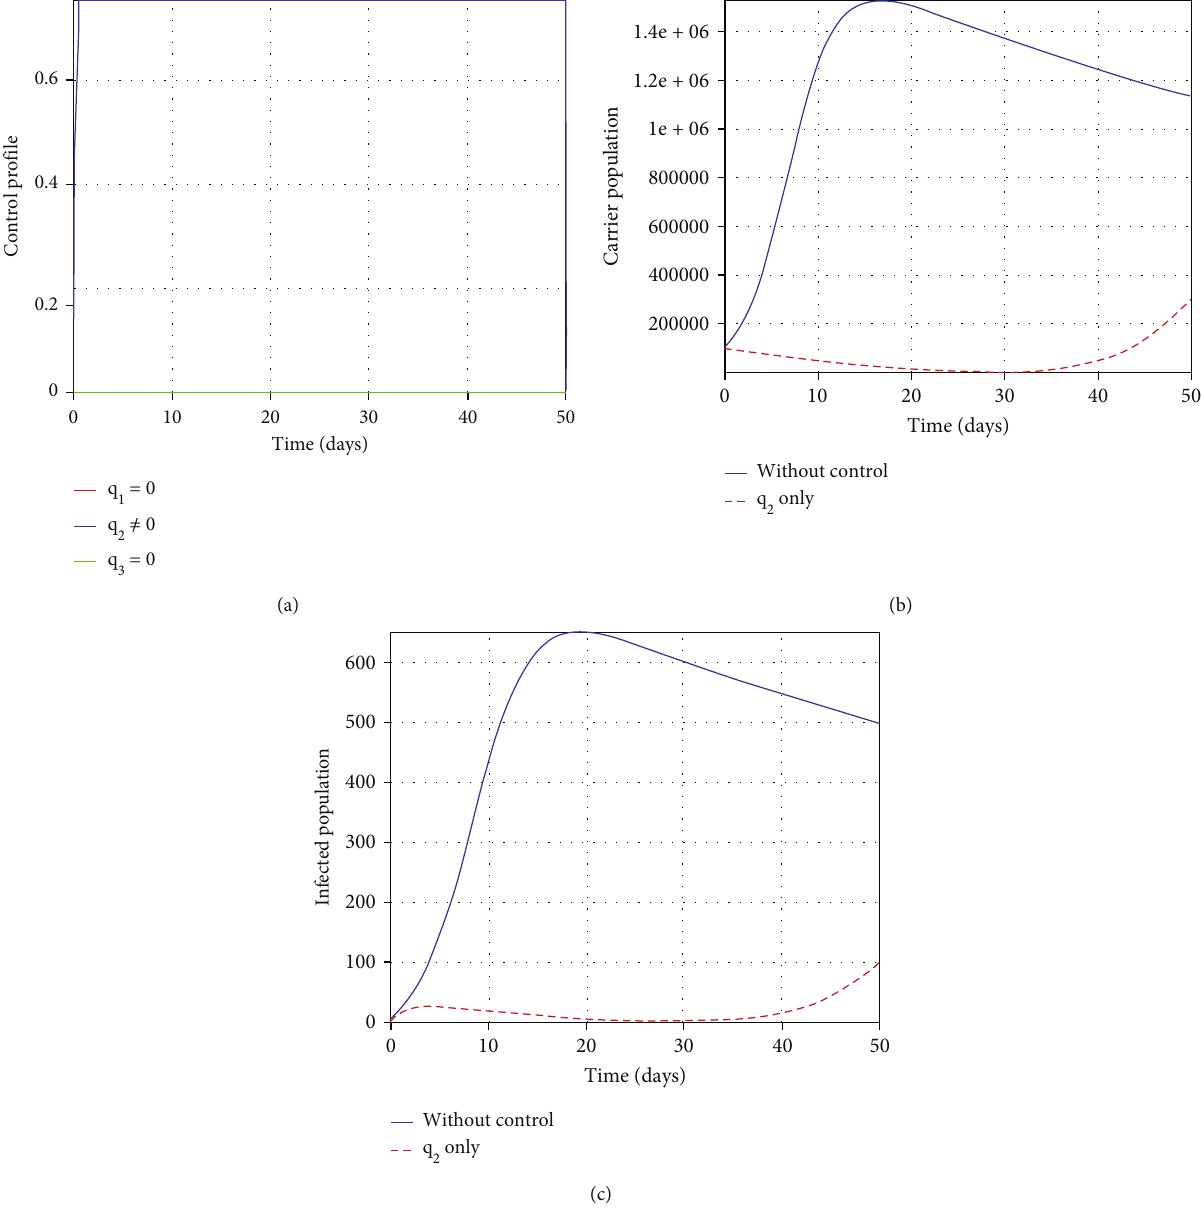
Figure 7: E ff ect of using treatment only. The control pro fi le associated with the use of treatment as the only intervention measure in (a) shows that about 15% of the population with meningitis should be treated on the initial day and afterward 80% of these carriers and infected individuals be treated throughout the entire period. Changes in (b) carriers and (c) infected individuals show that incorporating treatment reduces the number of secondary infections in the